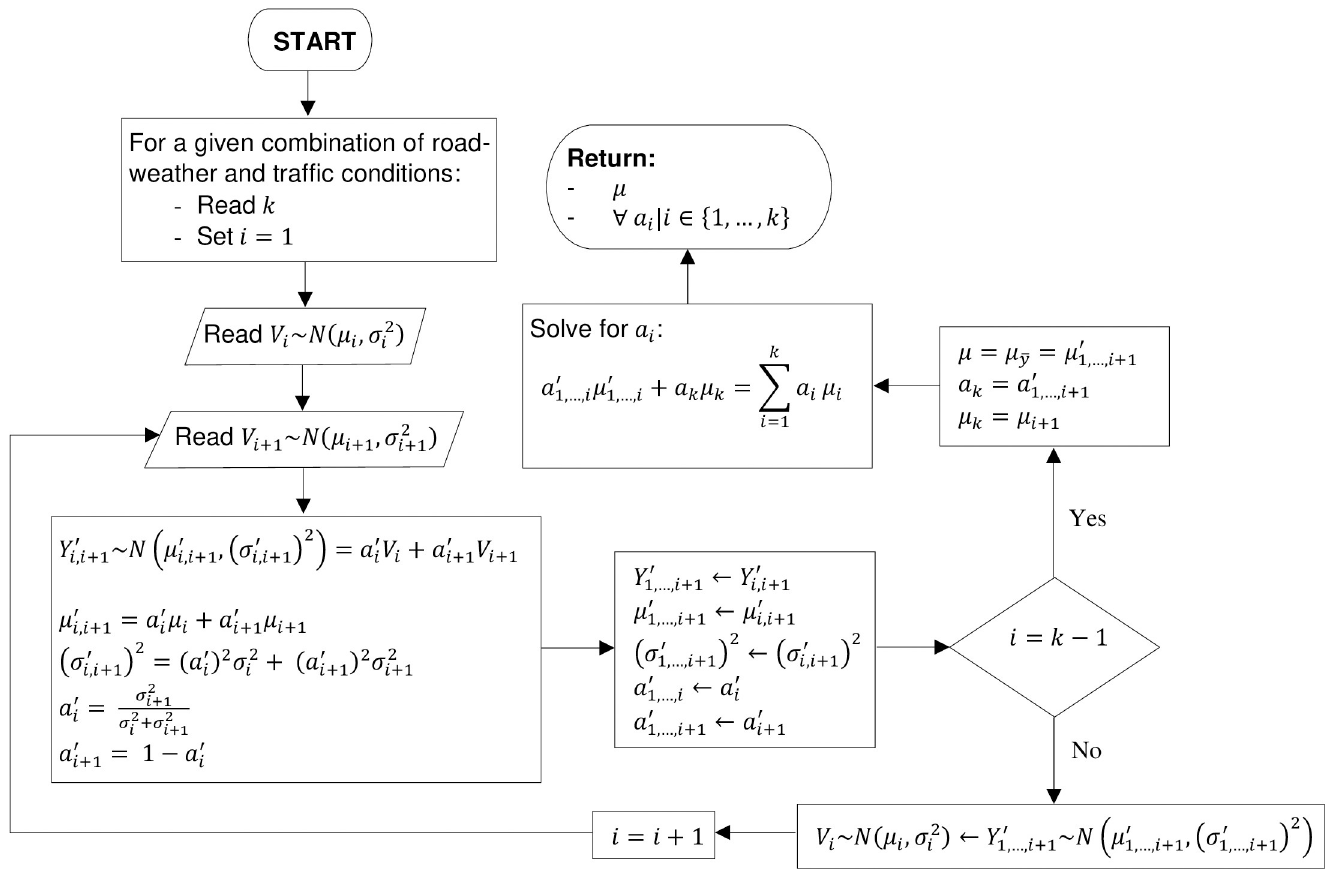
Fig 9. Algorithm for estimation of weight factors and μ